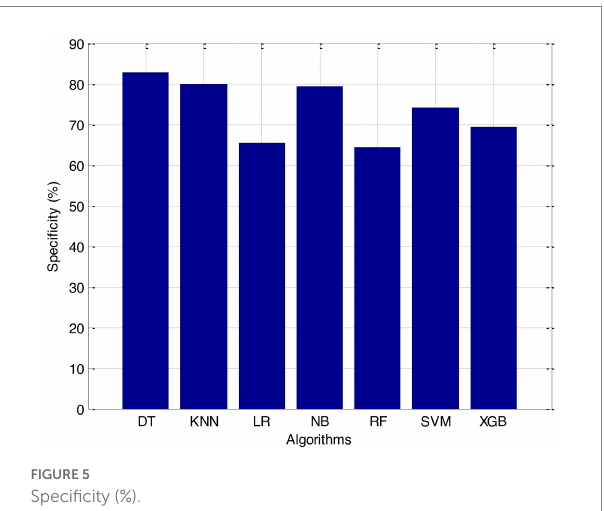
FIGURE 5 Specificity